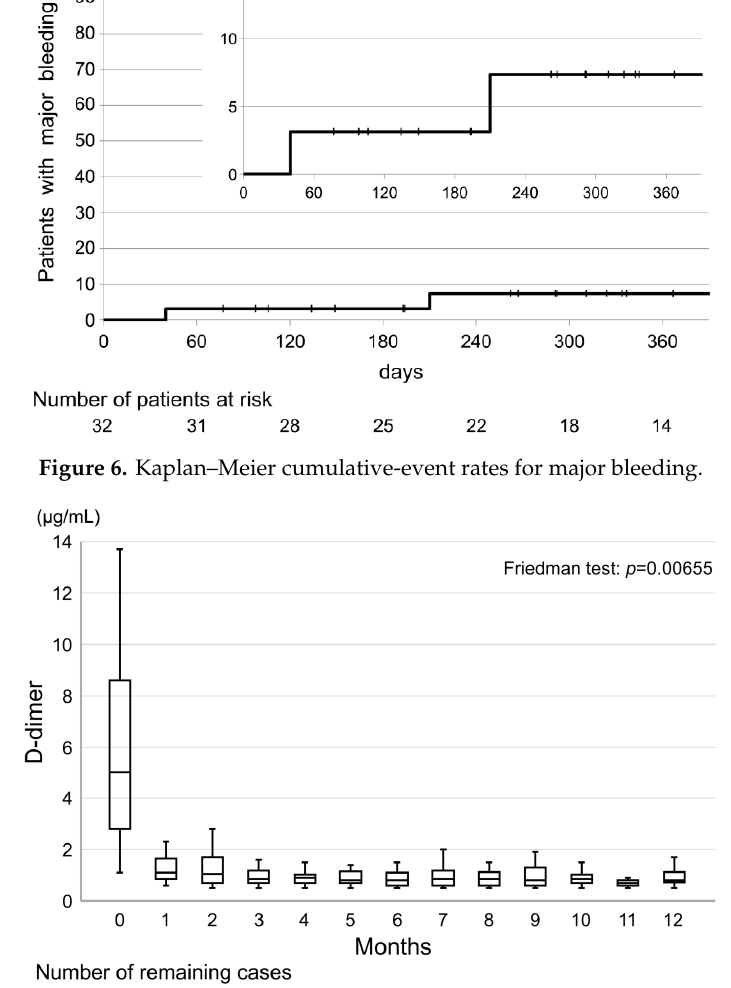
Figure 7. The transition of d-dimer levels during the overall analysis period.